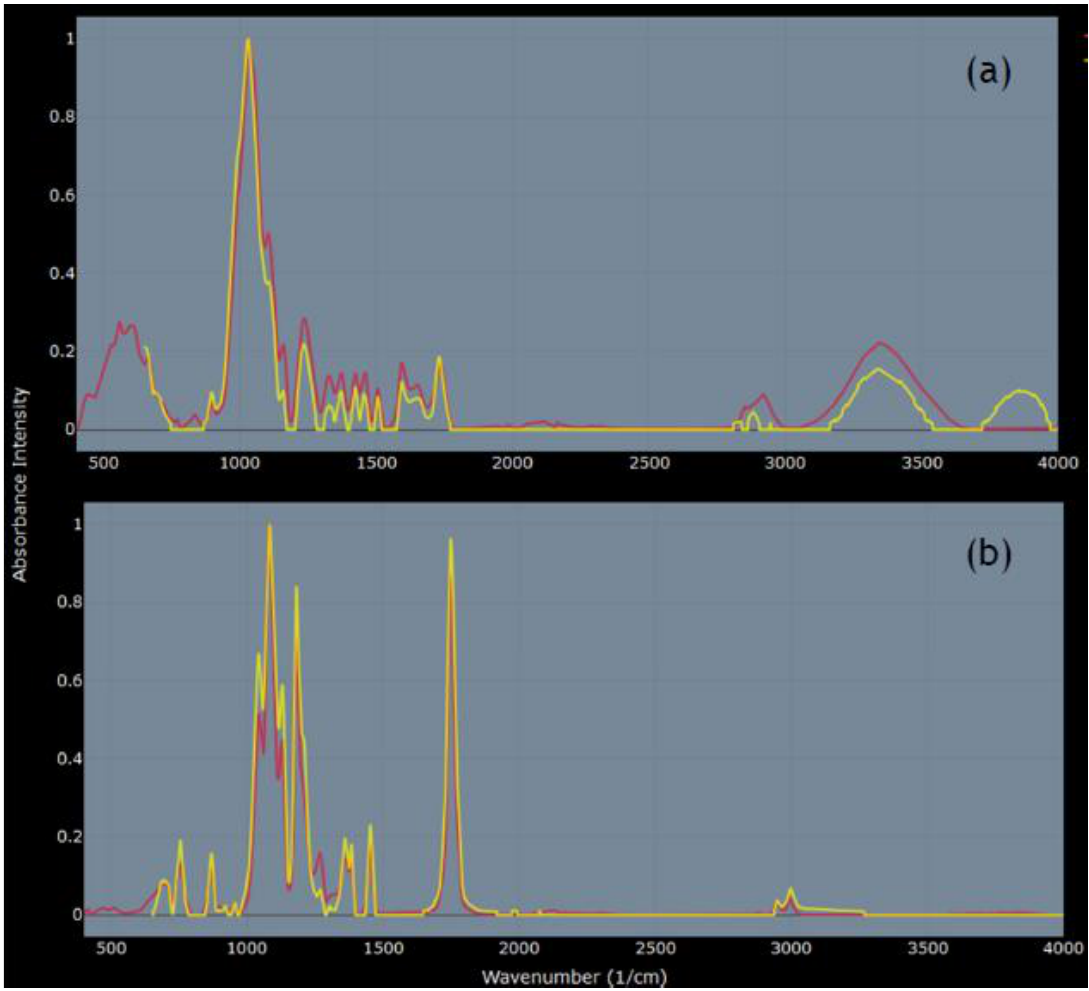
Figure 3. Comparisons of FTIR spectra on Open Specy [28]. ( a ) Yellow line: CS (plant-derived microparticles); red line: fiber poplar down [38], r = 0.96. ( b ) Yellow line: DP (body wash microplastic (MP)); red line: polylactic acid (PLA) [38], r = 0.99.